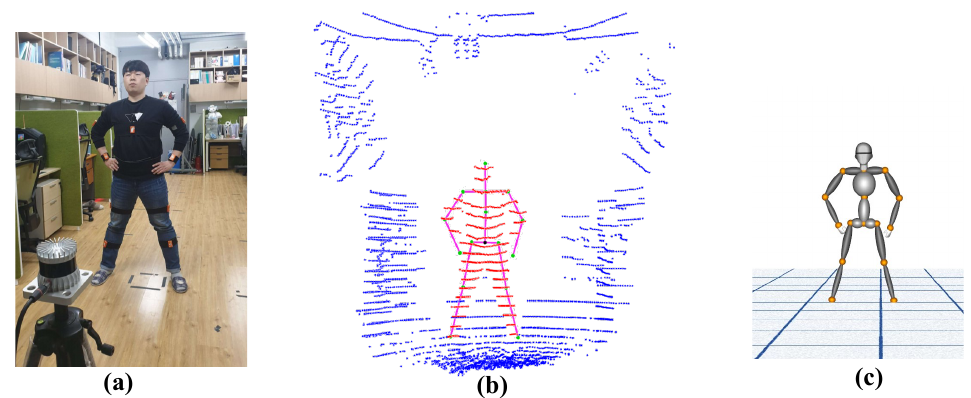
Figure 2. Proposed human tracking system overview: ( a ) Heterogeneous sensing experimental setup, ( b ) Detected user in lidar data and skeleton construction, ( c ) Reconstruction on 3D